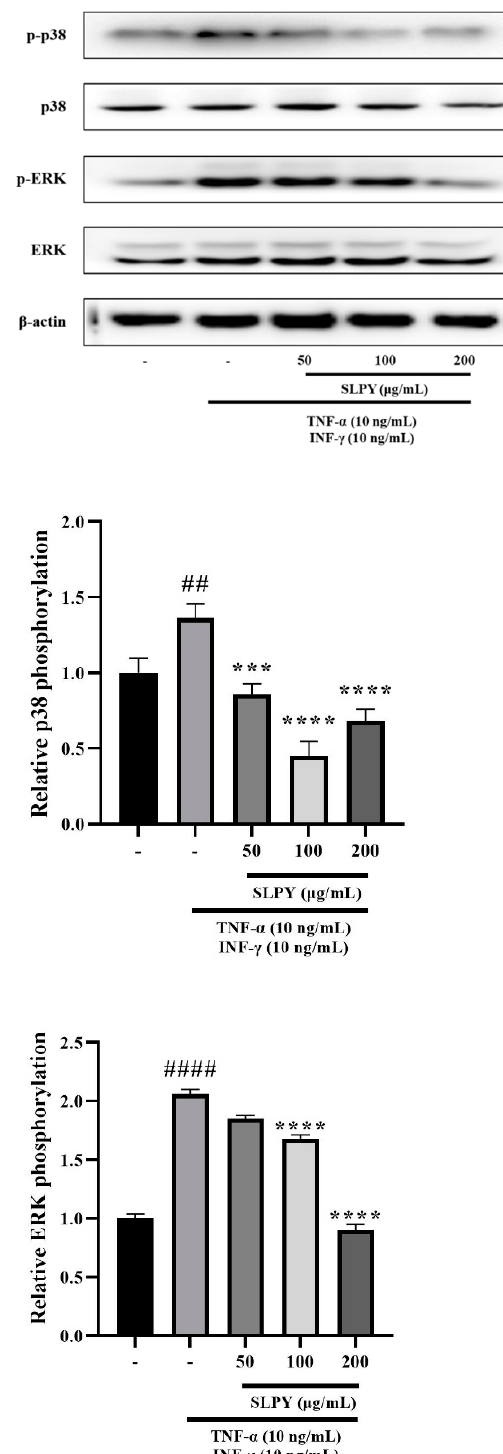
Figure 3. Effect of SLPY on expression levels of proteins linked to the mitogen-activated protein kinase (MAPK) signaling pathway in HaCaT cells. Cells were tested for three concentration levels of SLPY: 50, 100, and 200 µ g/mL after stimulation with interferon (IFN)- γ and tumor necrosis factor (TNF)- α at 10 ng/mL for 6 h. Values represent the mean ± SD of at least three replicates. ## p < 0.01 and #### p < 0.0001 vs. the corresponding control group and *** p < 0.001, **** p < 0.0001 vs. the corresponding TNF- α /INF- γ group. SLPY: steamed and freeze-dried powdered by-product of mature silkworm larvae of the Yeonnokjam